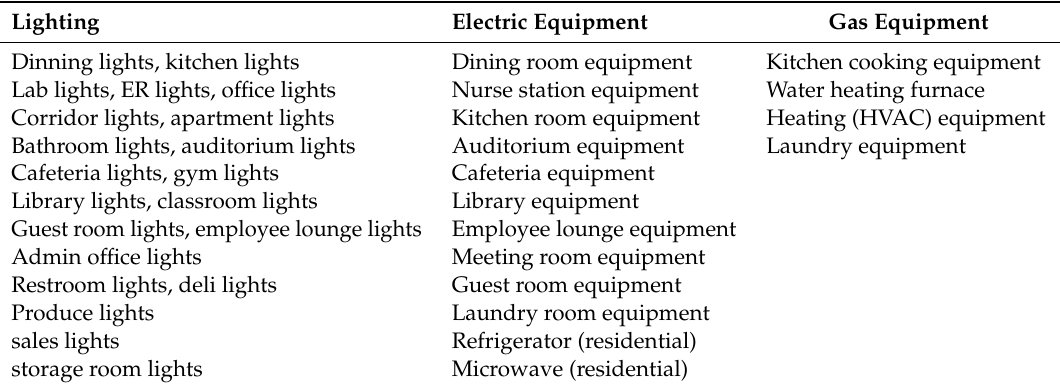
Table 6. Selected lighting, electric, and gas equipment inside